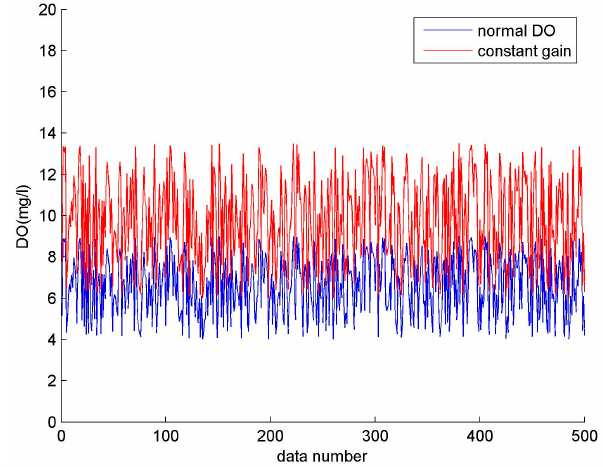
Figure 4. Constant gain (DO).